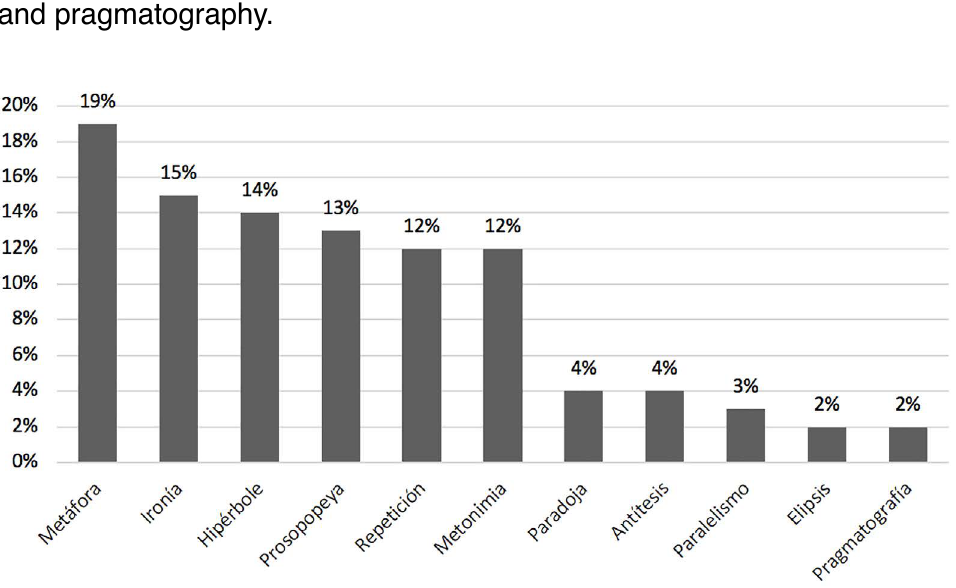
Figure 8. Percentage of original photographs produced by future teaching professionals using visual rhetorical figures. Source: